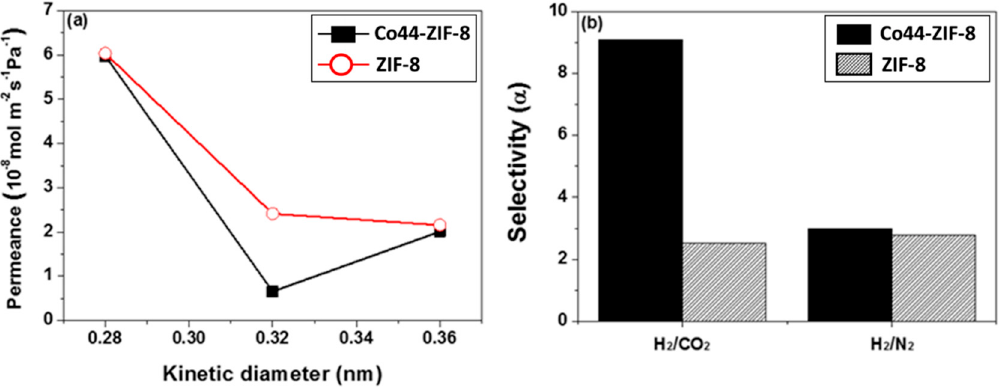
Figure 10. Permeances of single gases for ZIF-8 and Co44-ZIF-8 ( a ) as a function of the kinetic diameter (H 2 : 0.28, CO 2 : 0.32, and N 2 : 0.36 nm) at 25 °C and 0.1 MPa, and ( b ) the separation factors for H 2 /CO 2 and H 2 /N 2 .